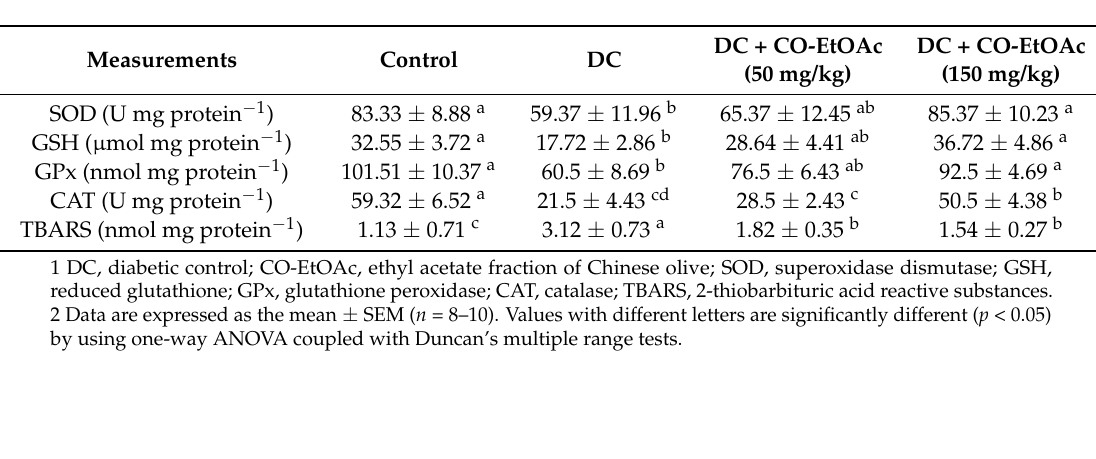
Table 3. Antioxidant status and TBARS levels of the liver in diabetic